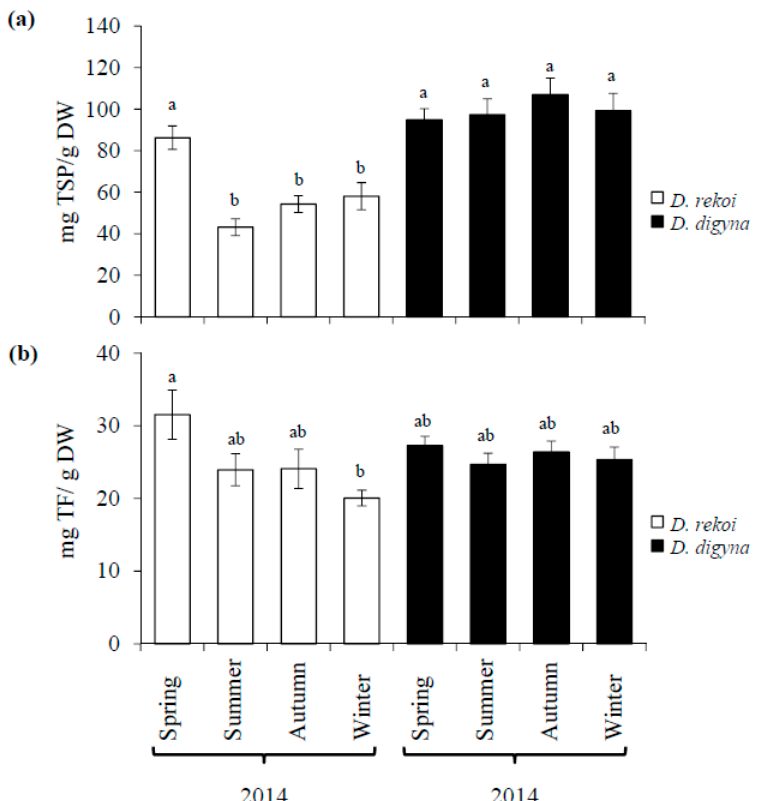
Figure 3. Seasonal variation of total soluble phenols (TSPs) and flavonoids (TFs) in leaves of Diospyros digyna and D. rekoi . Average seasonal variation in ( a ) TSPs and ( b ) TFs, expressed as caffeic acid and catechin equivalents, respectively, was determined in vitro in 60% aqueous methanolic leaf extracts of D. digyna and D. rekoi trees. The bars represent the mean values obtained from leaf extracts produced from the pooled leaves of five trees sampled in the spring, summer, autumn, and winter of 2014, respectively. Intervals over the bars represent the standard error of the means, whereas different letters over the bars represent statistically different values at p ≤ 0.05 (Tukey–Kramer test). DW = dry weight.